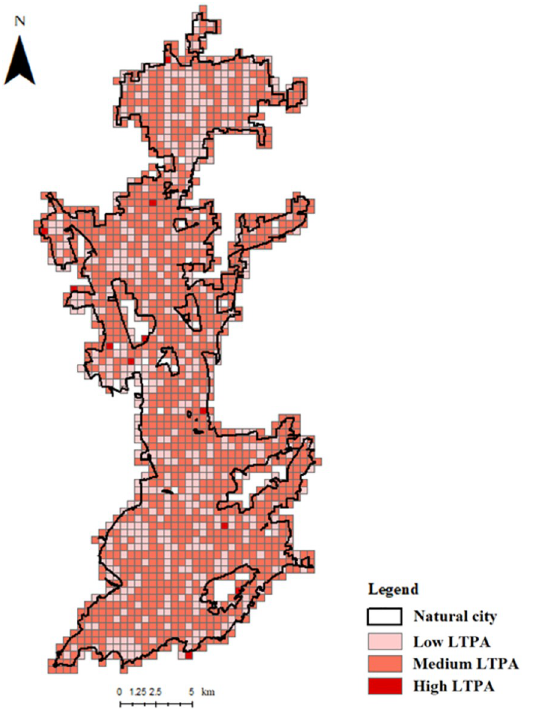
Fig 1. An example of the LTPA data in Qingdao city.